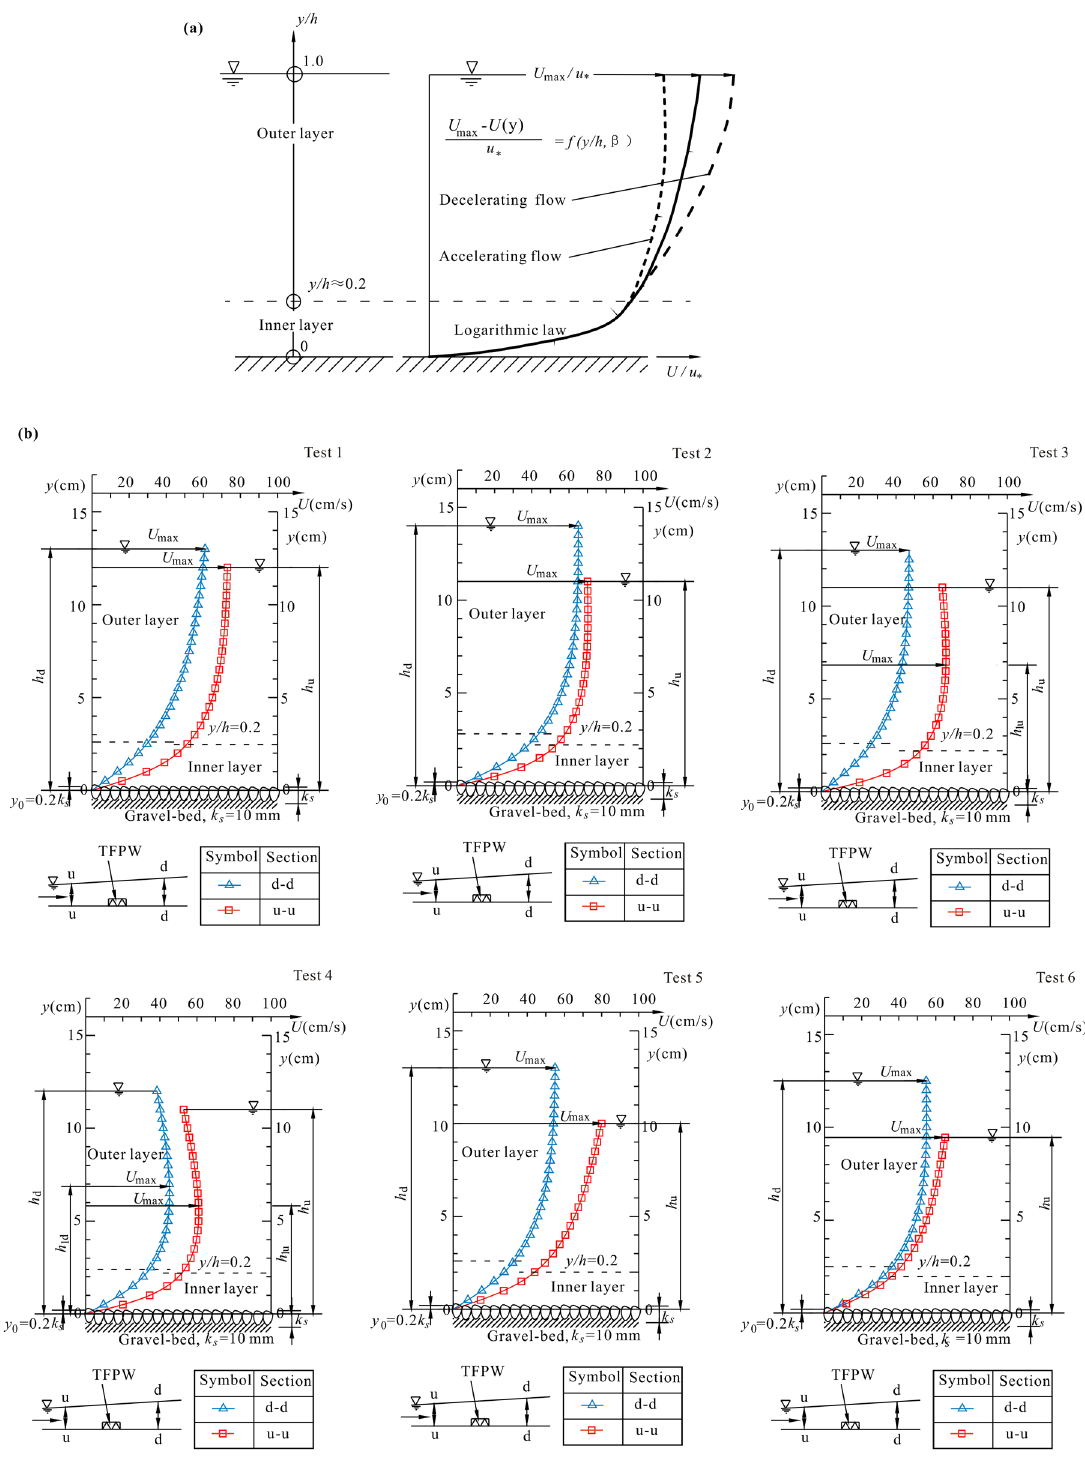
Figure 2. Velocity distribution: ( a ) schematic time-averaged velocity distribution of non-uniform flow (Graf, 1998) 31 and ( b ) vertical distribution curves of time-averaged velocity for the six different TFPW in this